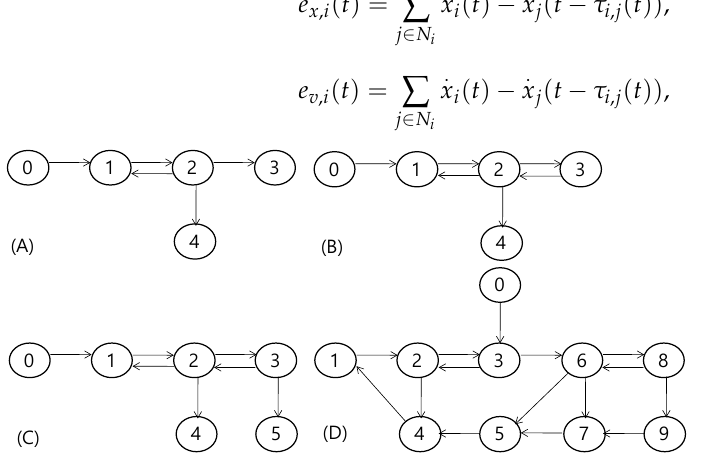
Figure 1. ( A – D ) Communication graphs for simulations.